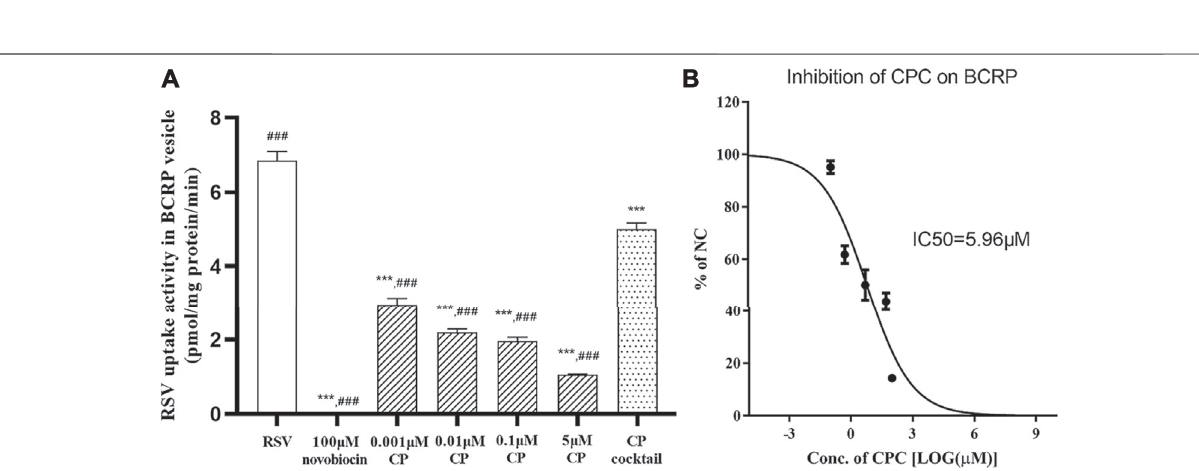
Frontiers in Pharmacology |